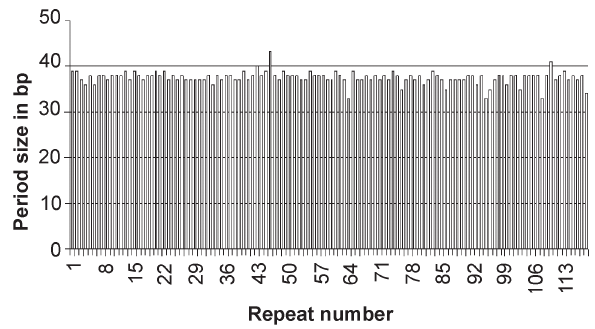
Figure 2. Distribution of the ATTTCAATCCCATTTTGGTCTGAT TTTAAC (30 bp) repeat within the complete genome sequence of M. thermoautotrophicus . The x -axis represents the number of unit length repeats, i.e., each consecutive occurrence of the repeat se- quence was assigned a number from 1 through n (repeat number) where n is the totalcopy number of the repeat within the genome. The y -axis represents the period distance or periodicity, i.e., the spacer length between consecutive